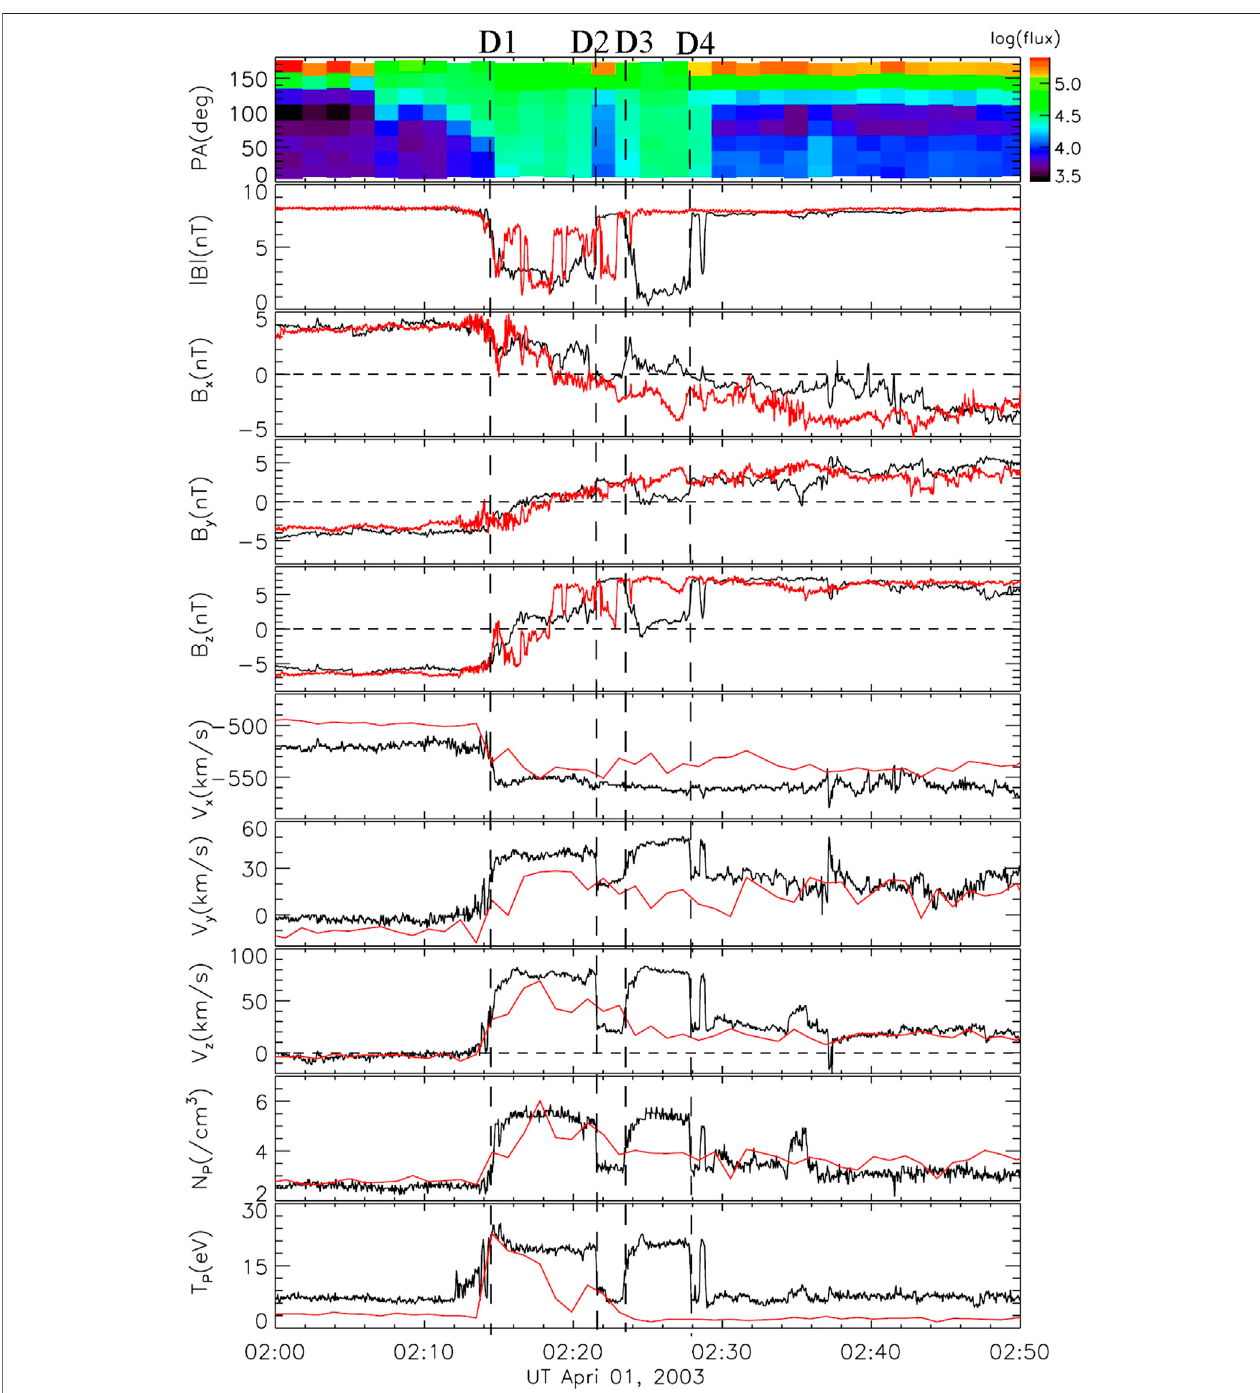
FIGURE 2 | Magni fi ed images of the suprathermal electron spectrogram, magnetic fi eld, and plasma data of the magnetic reconnection exhaust on April 1, 2003. The red cures indicate observations of ACE. Note that observations of ACE are shifted toward 22 min in time.